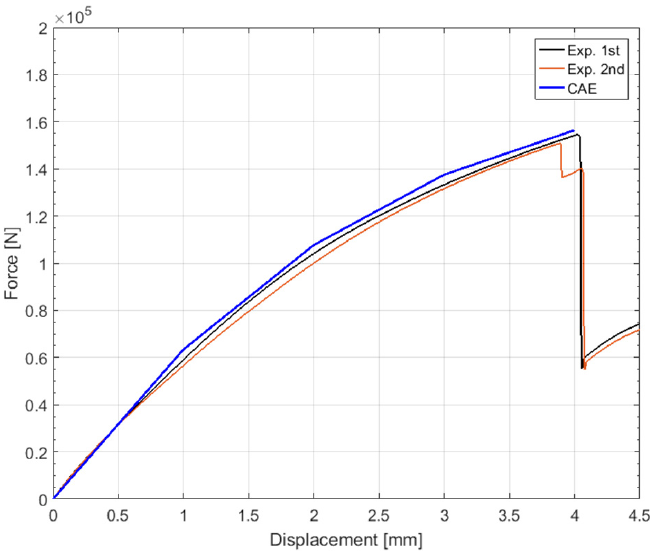
Figure 11. Comparison of load-displacement curve results through tensile test and structural analysis.